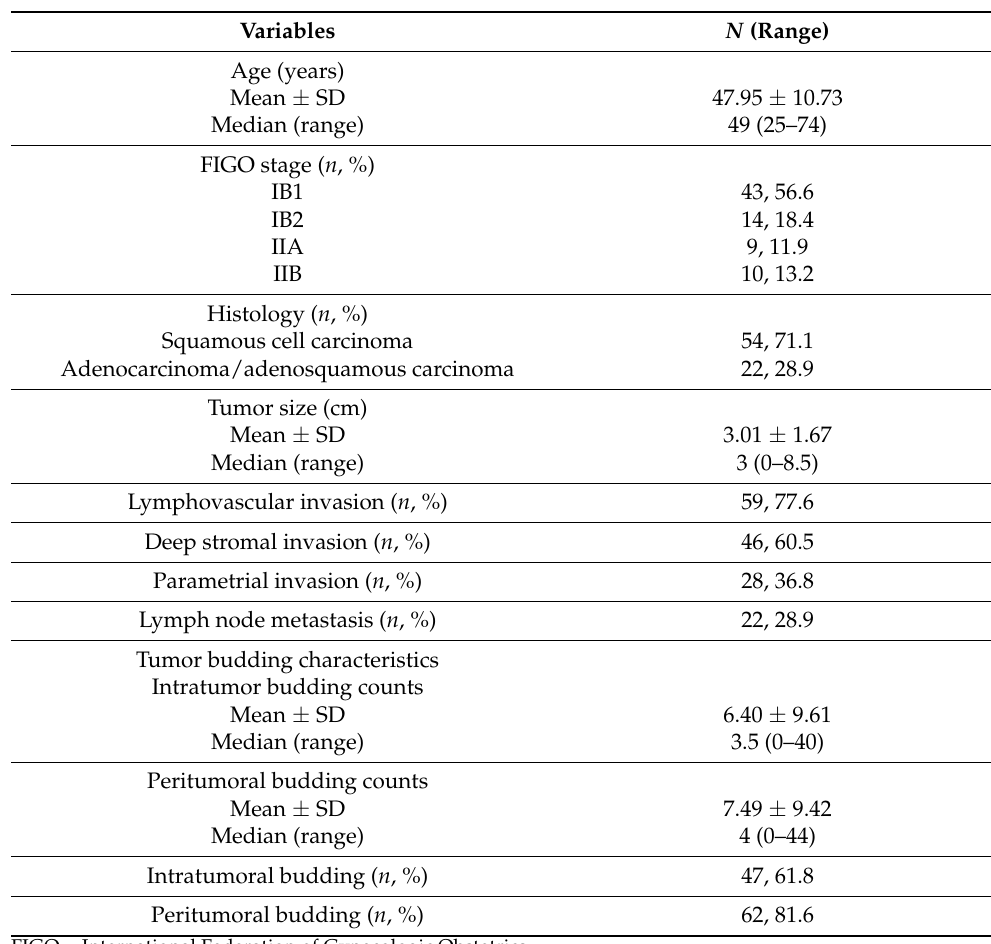
FIGO = International Federation of Gynecologic